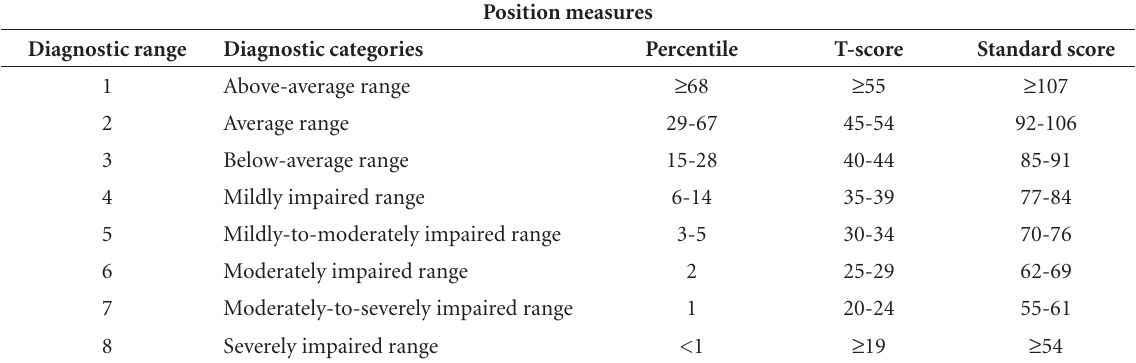
Table 1. Diagnostic ranges and standardized scores of position measures in the WCST 18,19 .